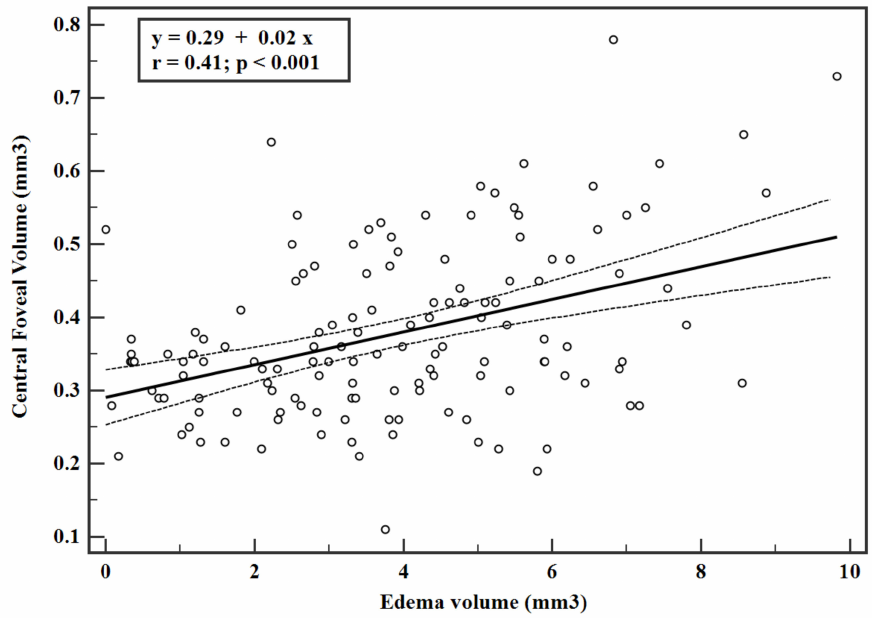
Figure 2. Linear regression with 95% confidence interval between central foveal volume and edema volume. Only eyes with an edema volume greater than zero were included in the regression. Volume was derived from the central sector of the ETDRS map.